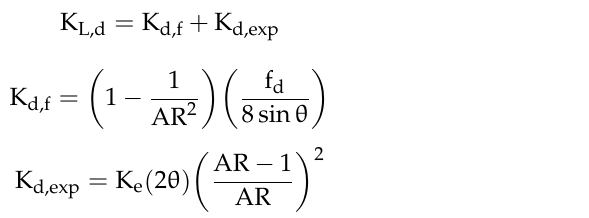
of the friction loss coefficient K d,f and the expansion loss coefficient K d,exp